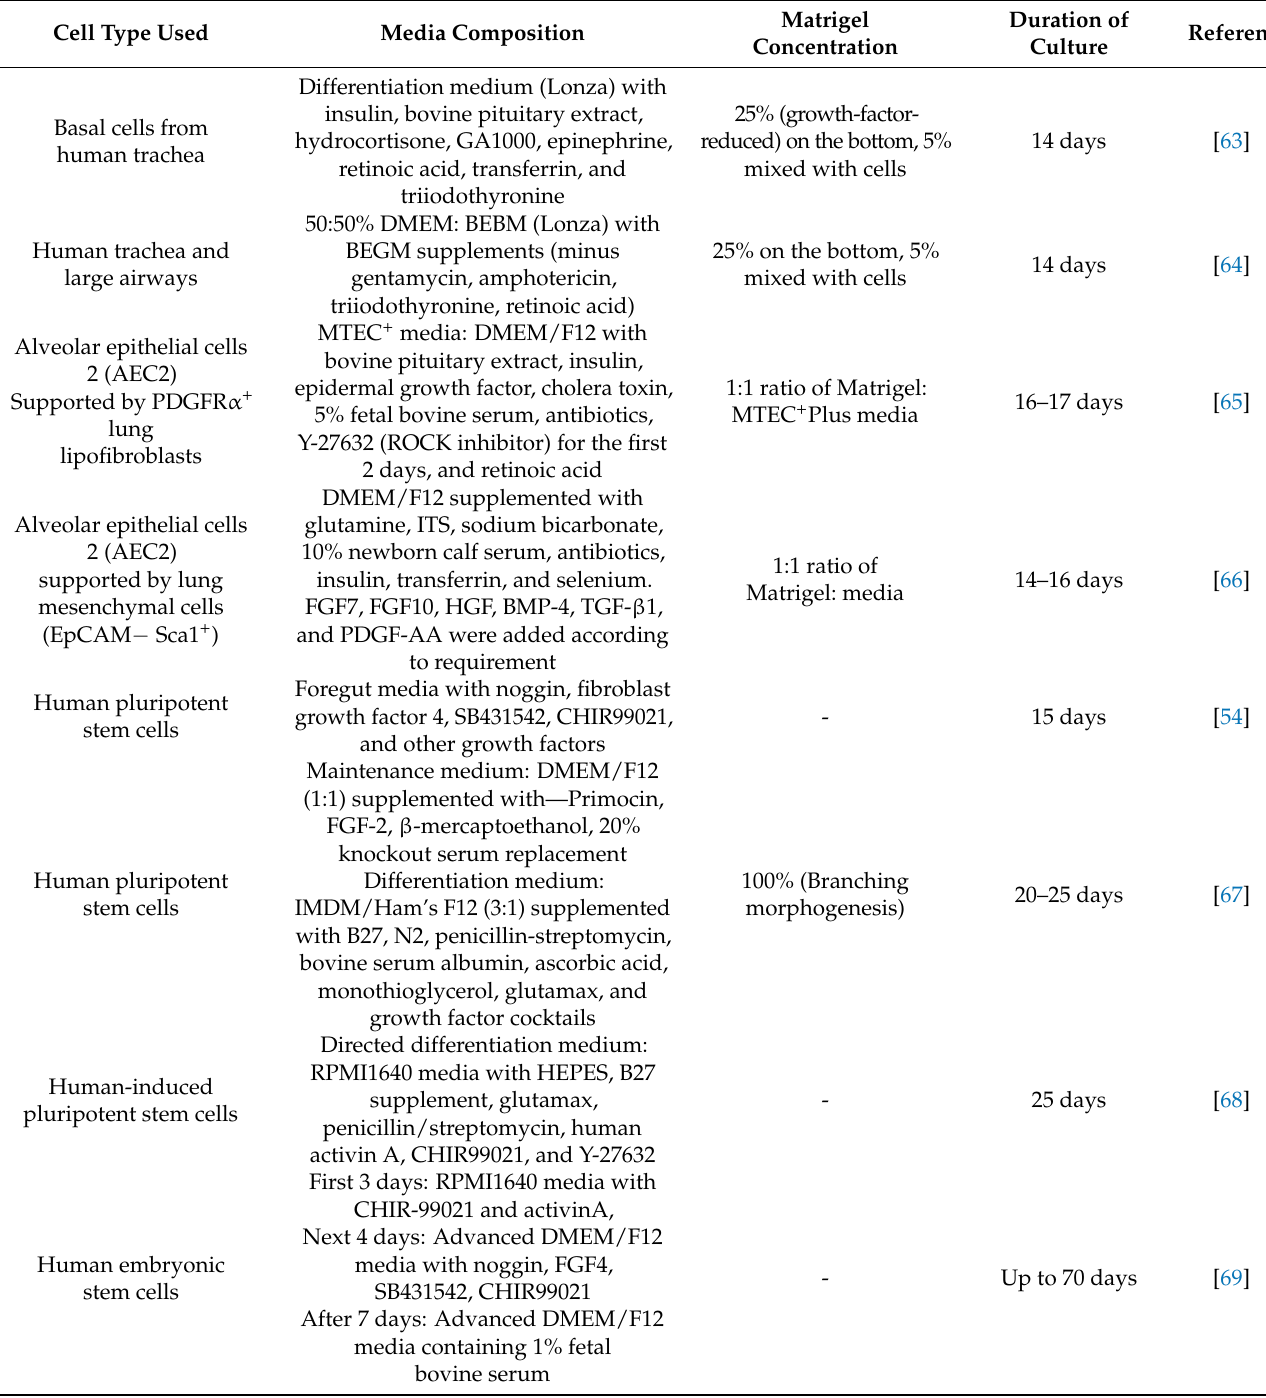
Table 1. Methods to generate organoids from different cell